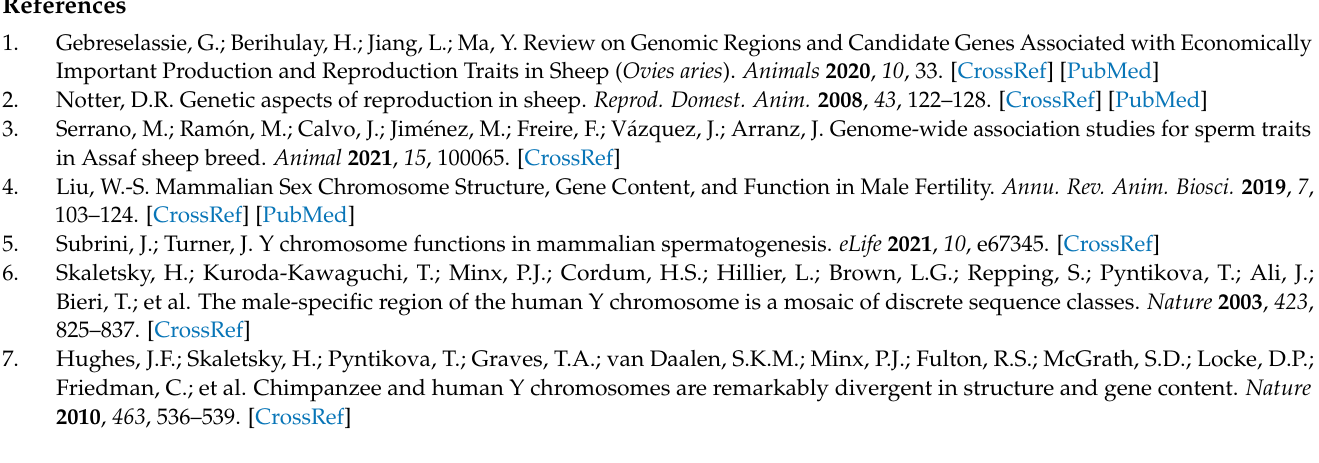
(F) Tertiary structures of ovine PRAMEY protein; Figure S3: Boxplot analysis of copy number of the PRAMEY among eight sheep breeds. The eight outliers in Hu sheep population are indicated by a solid circle. The x-axis represents the different sheep breeds. DP, Dorper; EF, East Friesian; HS, Hu sheep; SK, Suffolk; SMM, South African Mutton Merino; TS, Tan sheep; TL, Texel; WSK, White Suffolk; Figure S4: Scatter diagram reflecting the correlations between mRNA expression of PRAMEY and testicular parameters. The PRAMEY expression was positively associated with total epididymal weight (TEW: r = 0.865, p < 0.0001), total testicular weight (TTW: r = 0.766, p < 0.0001), and testicular index (TI: r = 0.676, p < 0.0001). Each black dot represents one individual; Table S1: The pairwise comparisons of the median copy number of PRAMEY among eight sheep